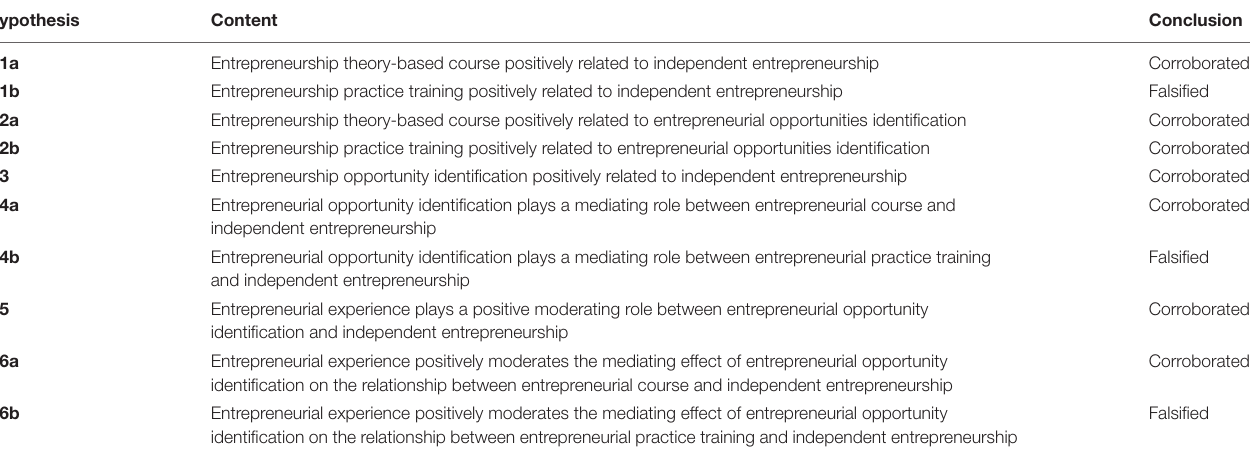
TABLE 11 | Summary of study hypothesis test results.